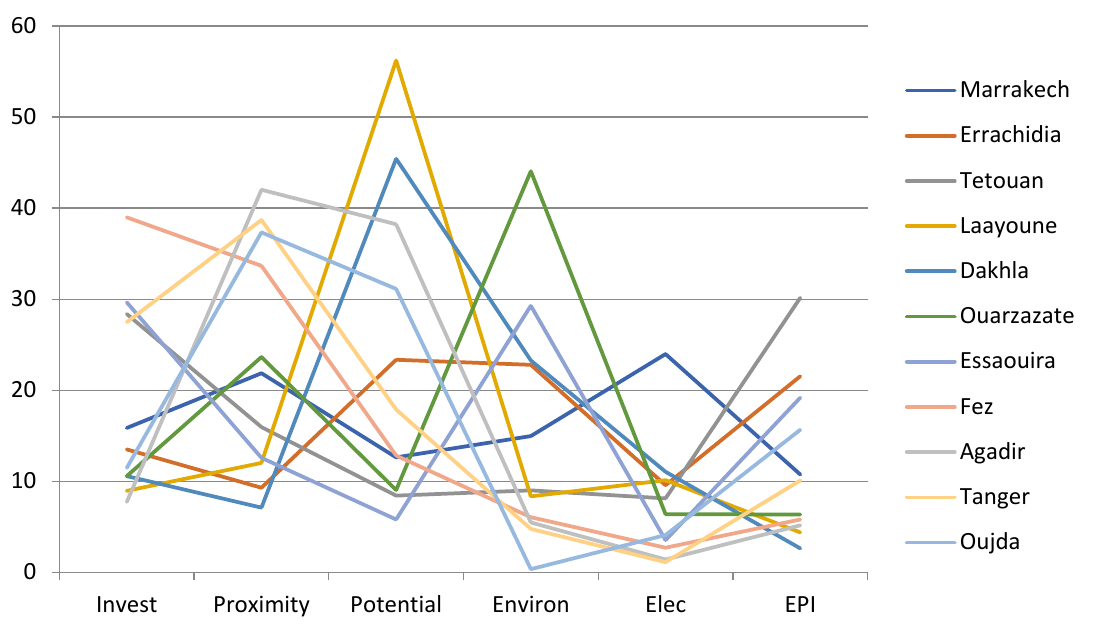
Figure 9. Third analysis with EPI as a new criterion. Central weights for the alternatives.